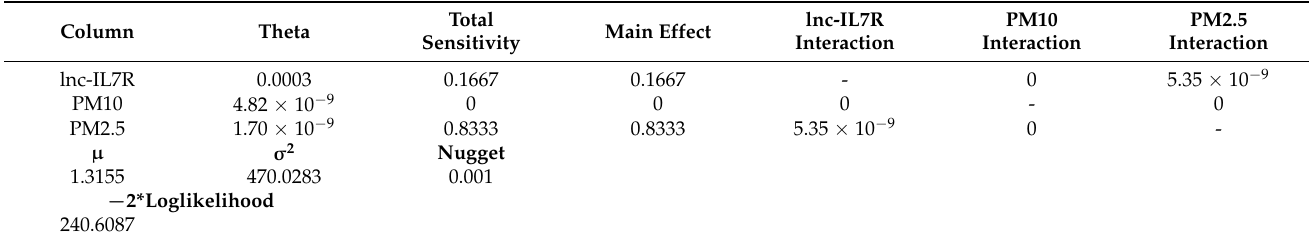
Table 2. Gaussian process model of %LAA-950insp-based COPD-E severity and progression: lnc-IL7R , PM 2.5 , and PM 10 . Column